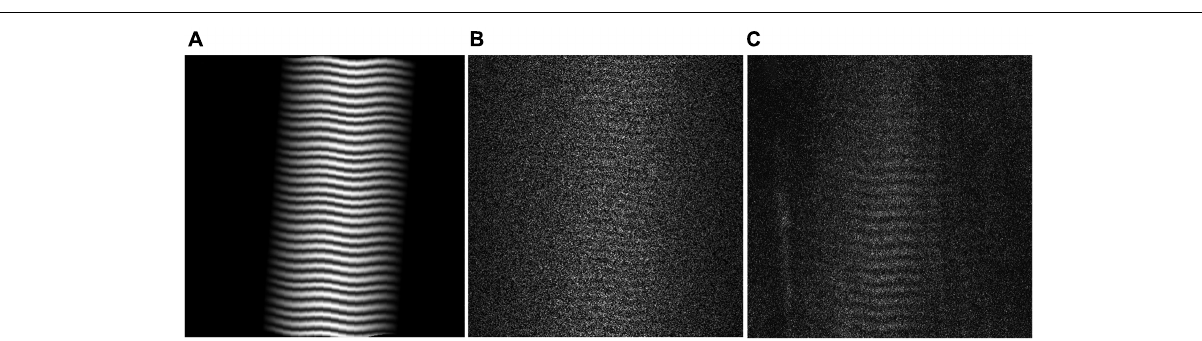
145 ± 108 images per trial. Mean sarcomere length per image was calculated using